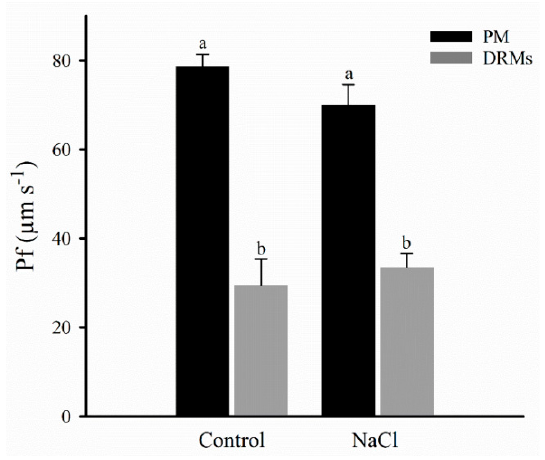
Figure 5. Osmotic water permeability, Pf , (µm s − 1 ) of plasma membrane (PM) and detergent-resistant membranes (DRMs) from broccoli roots treated with 0 (control) and 80 mM NaCl. Data are means ± SE ( n = 3). Analyses were done with three biological samples. Different letters represent significant differences according to two-way ANOVA and posterior Tukey-HSD test ( p < 0.05).